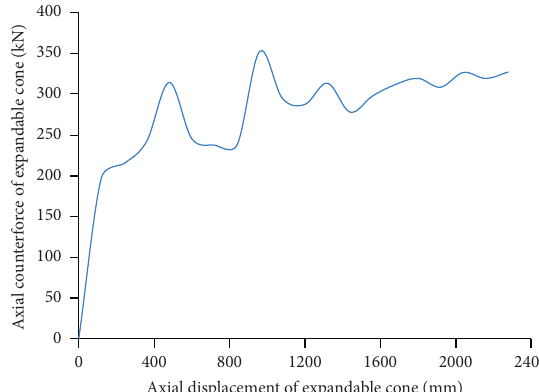
Figure 8: Expandable force generated on the expansion cone during the